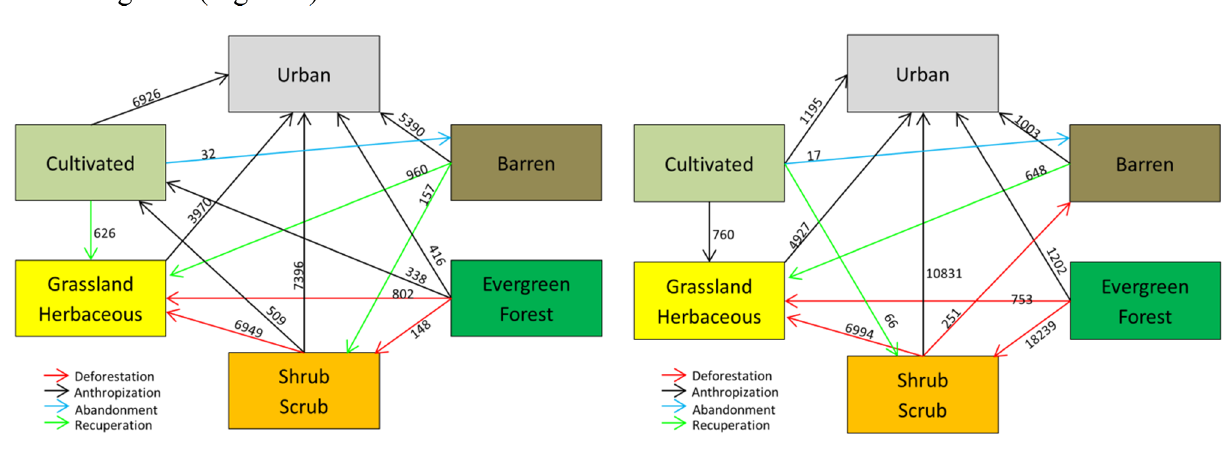
Figure 4. Land use and vegetation cover category transitions and transition processes. Numbers indicate change in hectares. Mexico ( left ); United States ( right